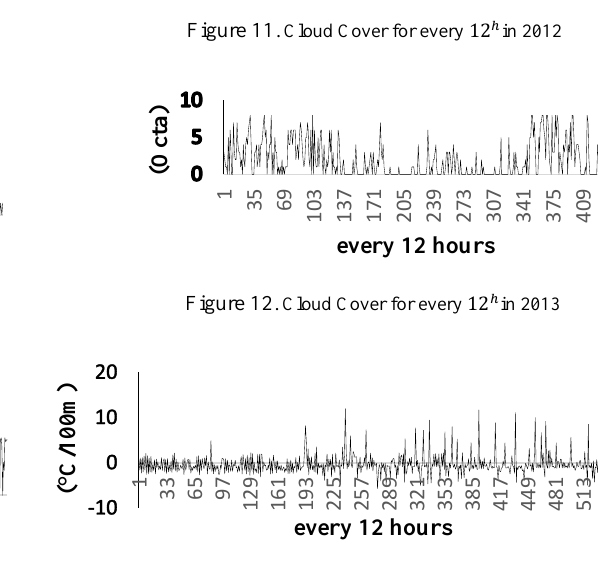
Figure 11 . Cloud Cover for every 12 ℎ in 2012